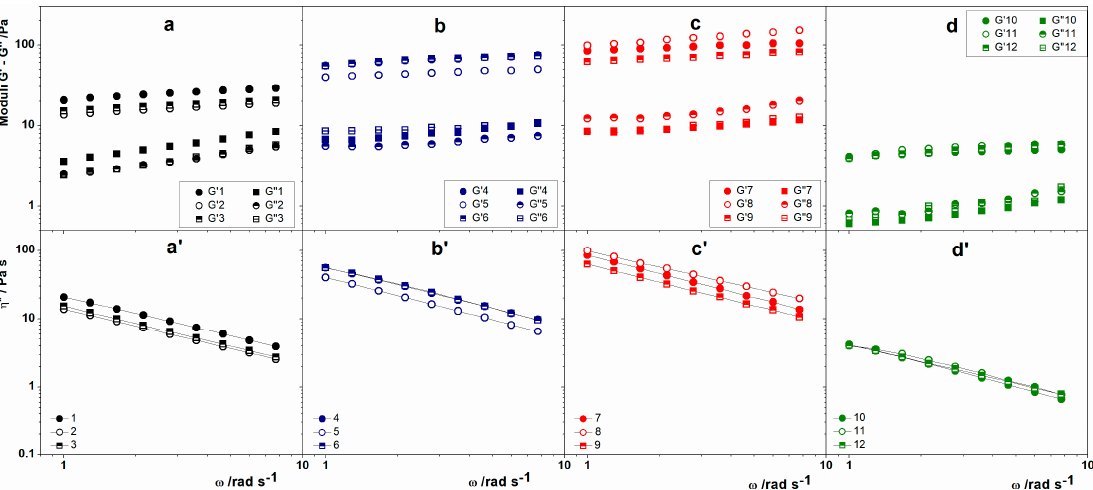
Figure 4. Frequency sweep and complex viscosity (indicated in figure by the letters a – d and a’ – d’ , respectively) for hydrogels produced with ( a – a’ ) low Ca 2+ content (black symbols), ( b – b’ ) medium Ca 2+ content (blue symbols), ( c – c’ ) high Ca 2+ content (red symbols), and ( d – d’ ) low alginate and medium* Ca 2+ content (green symbols). For detailed sample compositions, see Table 1.